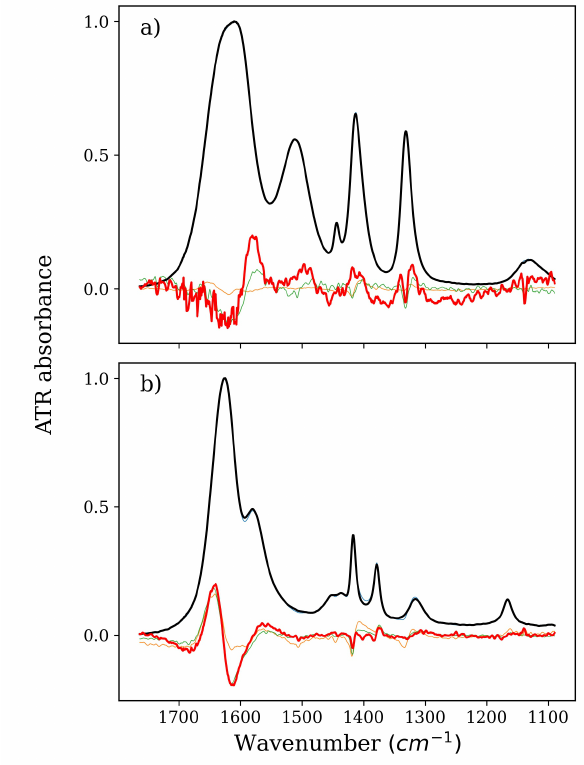
Figure 2. Spectra of pure GLY or NMA solution (thick black lines), derivatives (thick red lines), and isolated spectra of factors from a series devoid of ( a ) water and NMA or ( b ) water and GLY (all other thin lines). Part ( a ), therefore, denotes GLY, and Part ( b ) denotes NMA, both corresponding to the green and magenta series in Figure 6b,